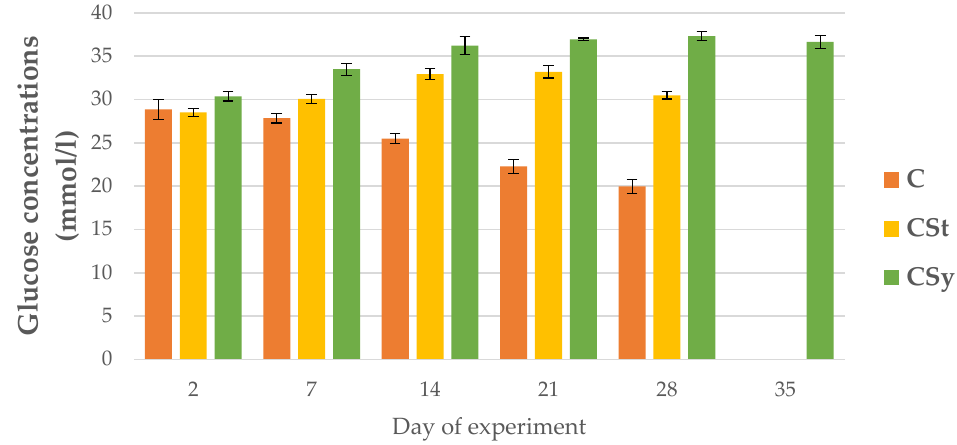
Figure 11. Glucose concentrations in the 2, 7, 14, 21, 28, 35-day-old workers’ hemolymph after two methods of supplementation with hemp extract: C-control (pure sugar syrup), CSy-hemp extract in syrup, CSt-hemp extract on strips. Two-Way ANOVA: supplementation method: F (2, 156) = 195.30, p = 0.0000, se ± 0.388458–0.351048; days of supplementation: F (4, 143) = 63.193, p = 0.0000, se ± 0.217085 – 0.125334; supplementation method × days of supplementation F (8, 143) = 249.21, p = 0.0000, se ± 0.217085 – 0.228828.